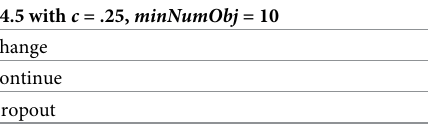
Table 6. Performance for each class in the sample.